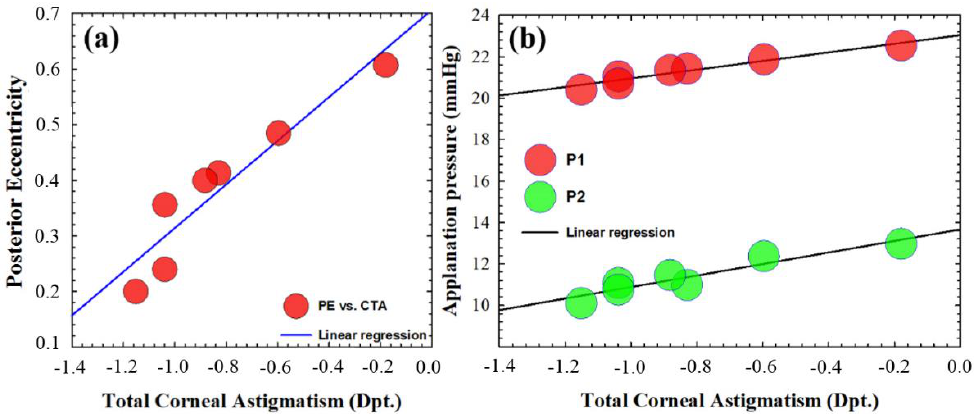
Figure 8. Mean clustered posterior eccentricity versus total corneal astigmatism values ( a ) and mean clustered applanation pressures at ORA versus total corneal astigmatism values ( b ). Linear regression fits are included.